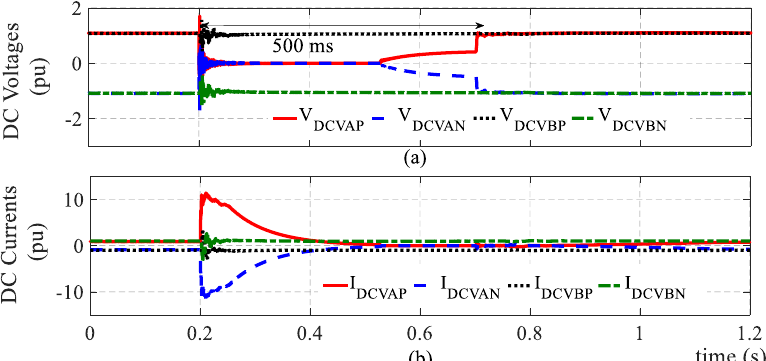
Figure 16. DC side measurements at LCC stations for a P-Pole-to-N-Pole fault on VSC branch-A ( a ) voltages, ( b ) currents.